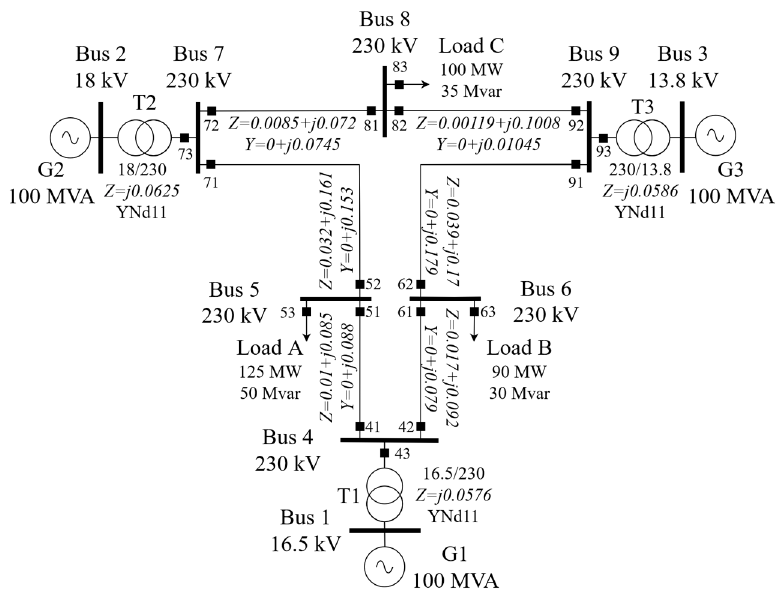
Figure 1. Standard IEEE nine-bus test system.